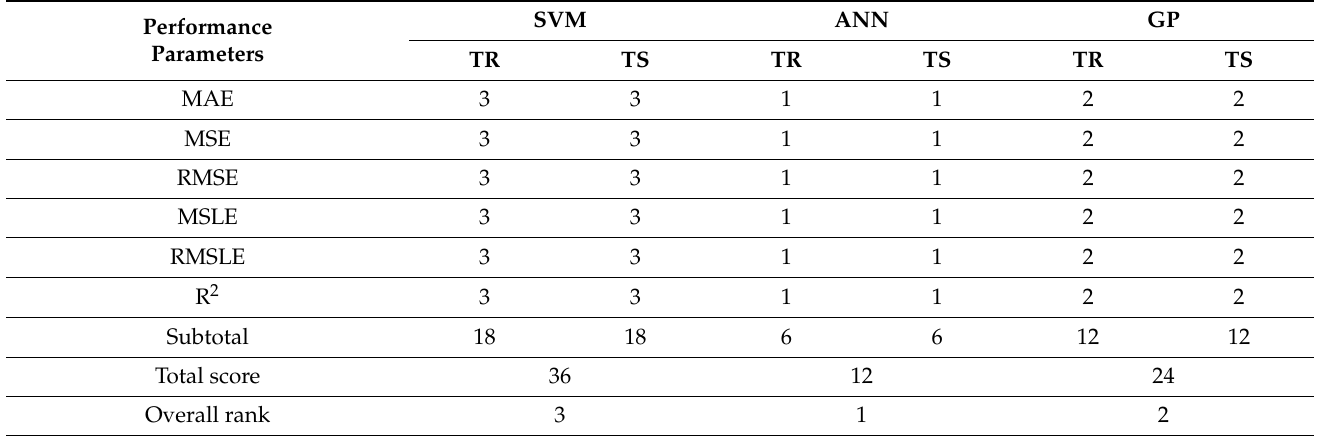
Table 10. Overall rank analysis of different performance parameters for different machine learn- ing